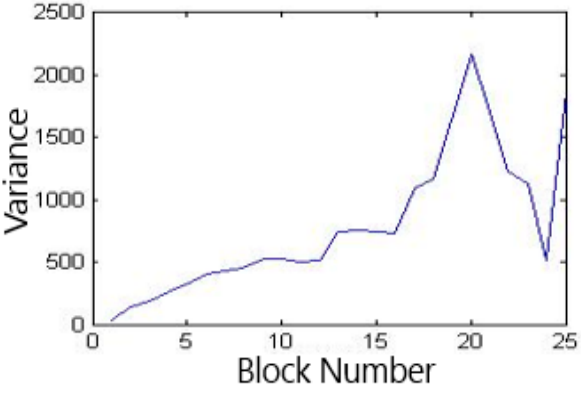
Figure 11. The variance of the average entropy matrix.